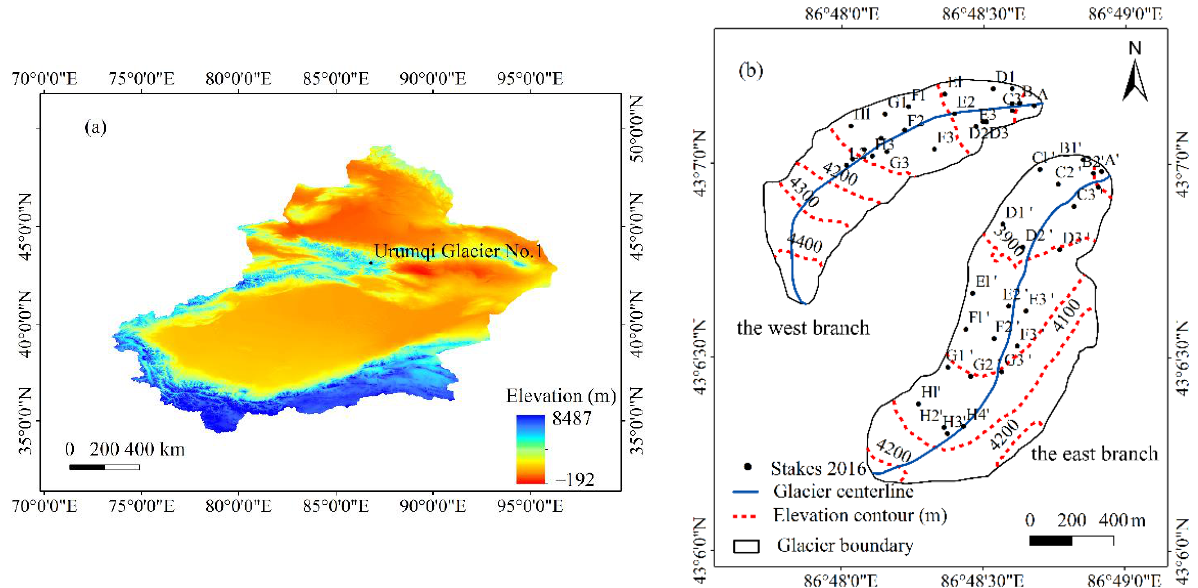
Figure 1. Study site description: ( a ) Location map of Urumqi Glacier No.1; ( b ) Sketch view of the study, including the locations of Urumqi Glacier No.1 and stakes in 2016.